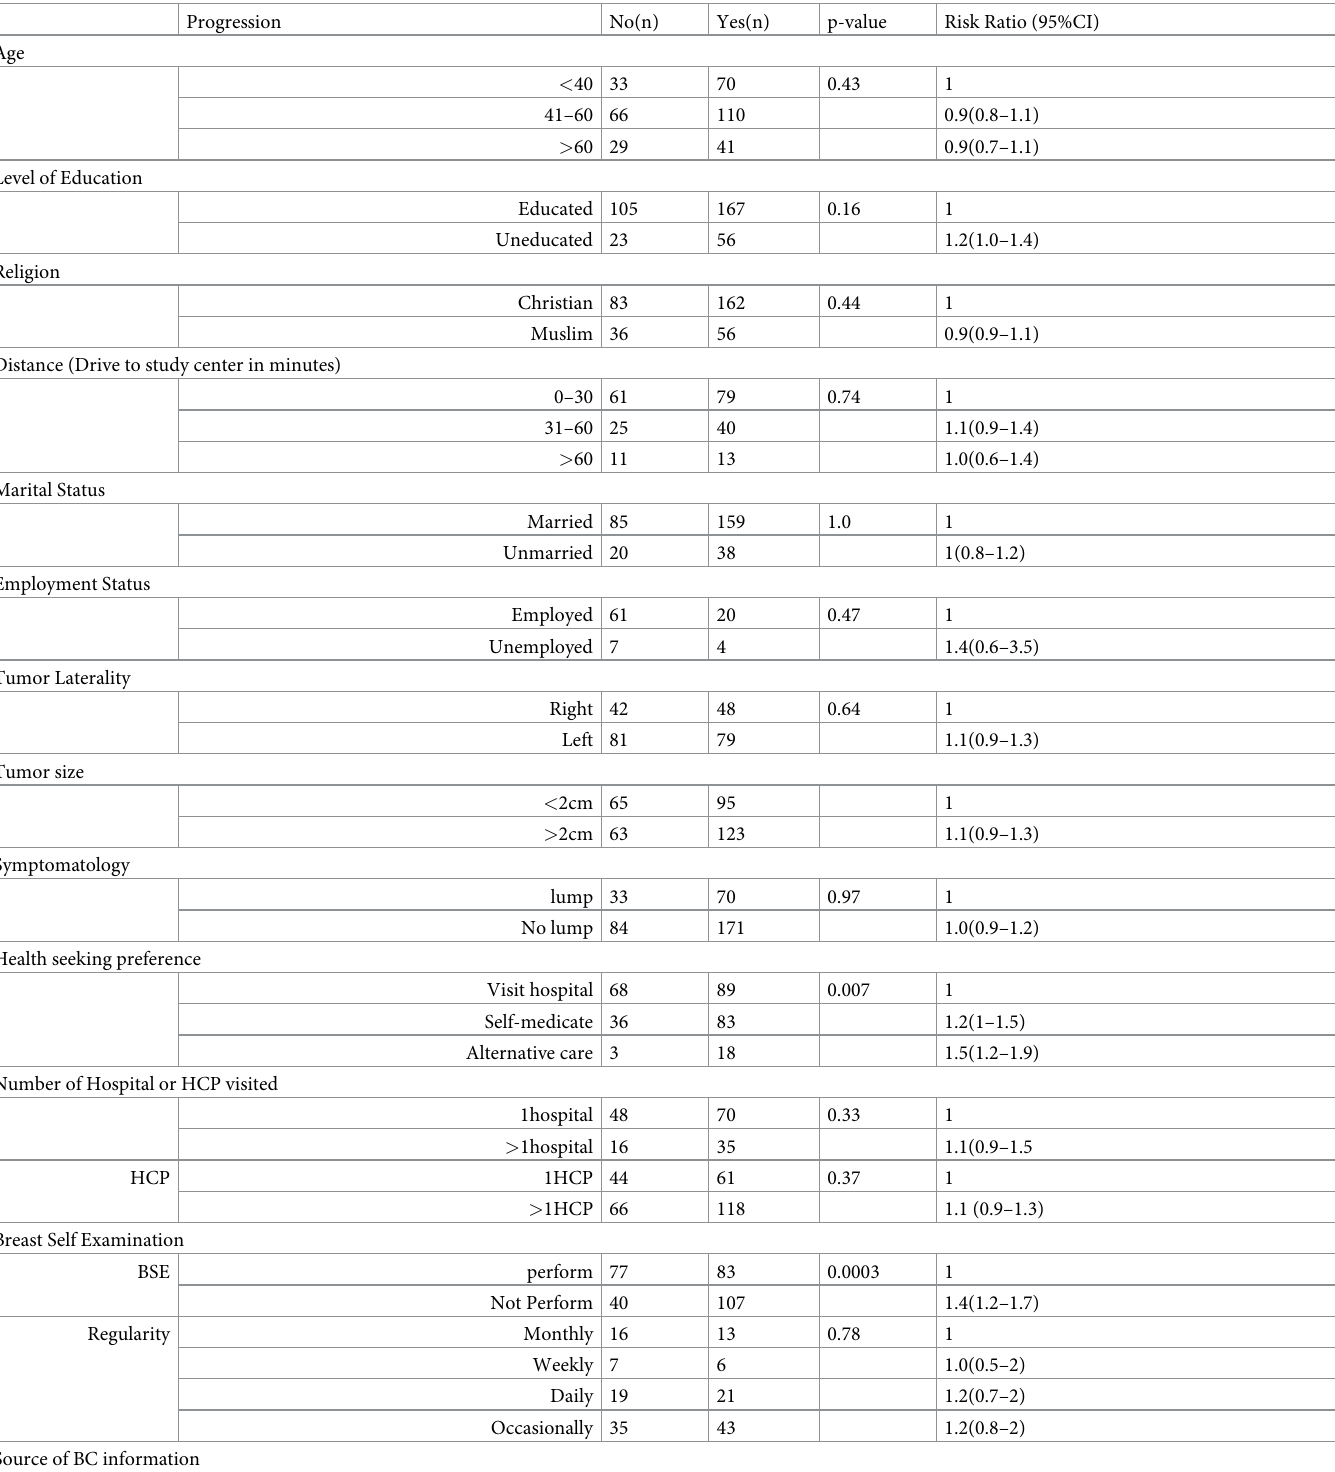
Table 3. The effect of the demographics and socioeconomic factors, symptomatology, premorbid preferences, and level of breast cancer information on the risk of disease progression after early detection and the probability of disease progression in the presence of barriers to early